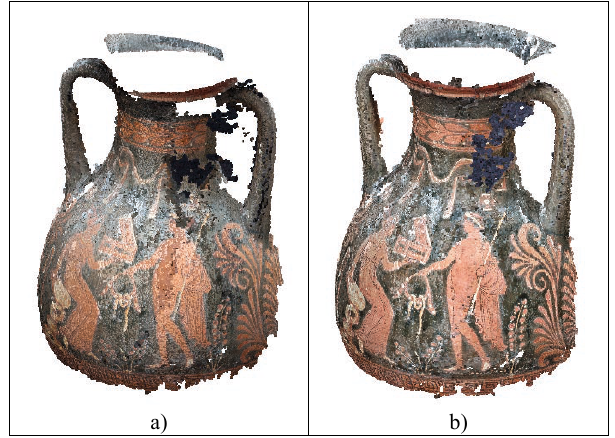
Figure 8. Image matching result from the images originated with different HDR processing: a) No HDR; b) tone mapped images from HDR processing.